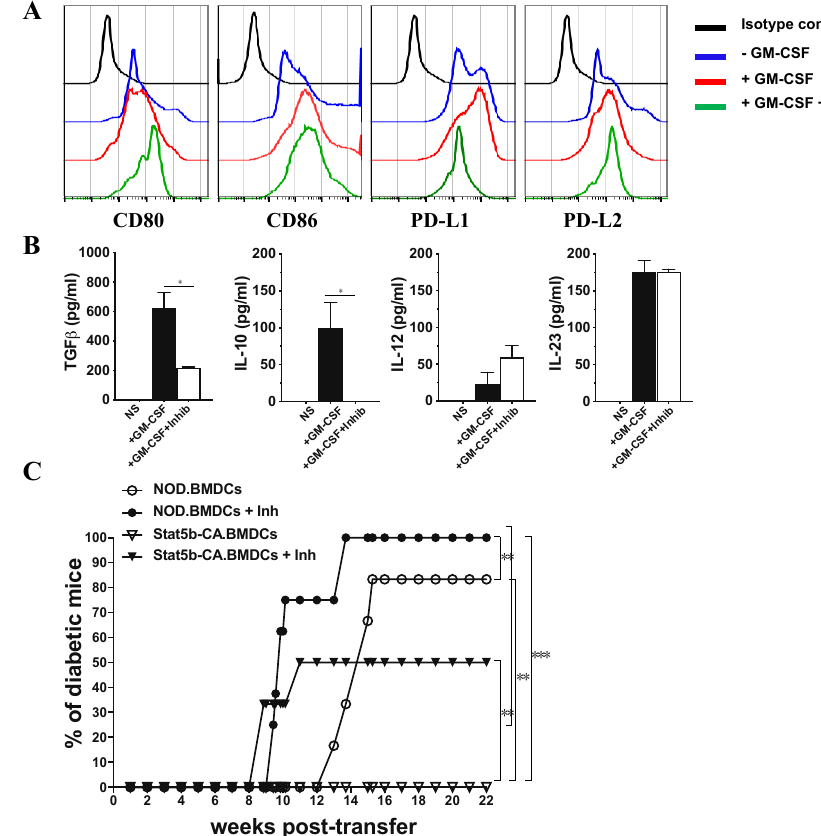
Figure 6. Inhibition of Ezh2 in Stat5b-CA-expressing BMDCs disturbs their tolerogenic signature and their capacity to protect against diabetes in NOD mice. ( A , B ) Stat5b-CA.BMDCs were pre-incubated for 1 h with the Ezh2 inhibitor GSK343 (3 µ M) or vehicle (0.1% DMSO), then cultured for 48 h in the absence or presence of GM-CSF (50 ng / mL) and analyzed for ( A ) the expression of CD80, CD86, PD-L1, and PD-L2 by FACS and ( B ) production of cytokines (TGF β , IL-10, IL-12, and IL-23) by ELISA. ( C ) BMDCs derived from NOD or NOD.CD11c Stat5b-CA mice were cultured in vitro with Ezh2 inhibitor GSK343 (3 µ M) or vehicle (0.1% DMSO). DCs were washed and i.v. injected (10 7 cells / mouse) to 8-week-old female NOD mice (6 mice per group). Recipient NOD mice were followed for diabetes development until 26 weeks (22 weeks post-injection) of age. The asterisks indicate statistically significant di ff erences determined by one-way ANOVa with Tukey’s post-test. p < 0.05 (*). For diabetes development, data were analyzed by Gehan–Breslow–Wilcoxon test. p < 0.01 (**) and p < 0.001